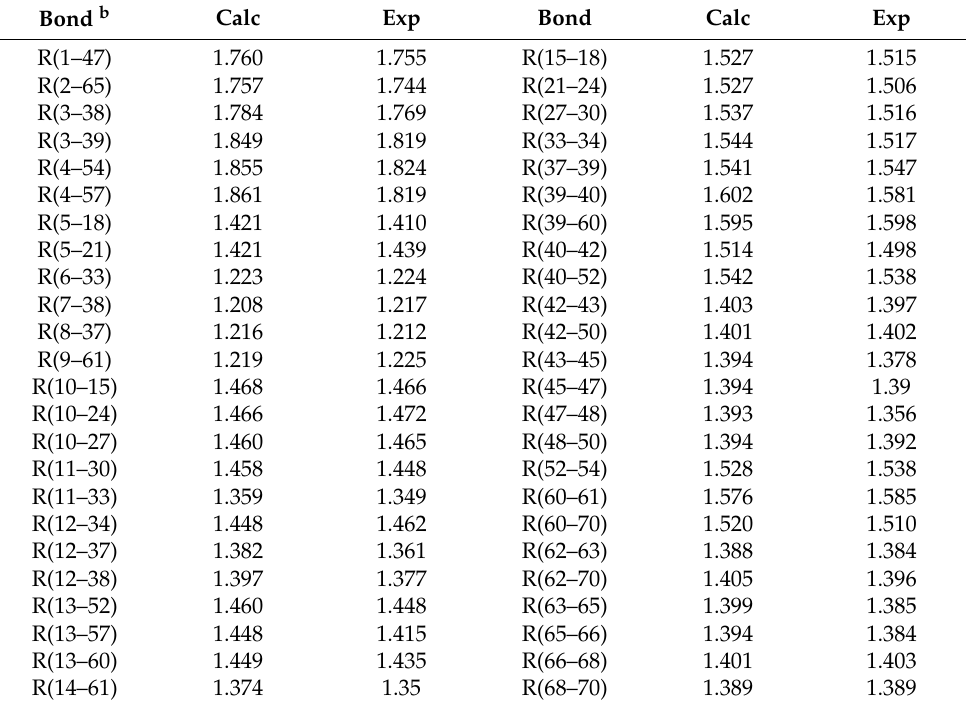
Figure 6. The optimized geometry ( a ) and overlay of the optimized geometry with experimental structures ( b )for 5a .